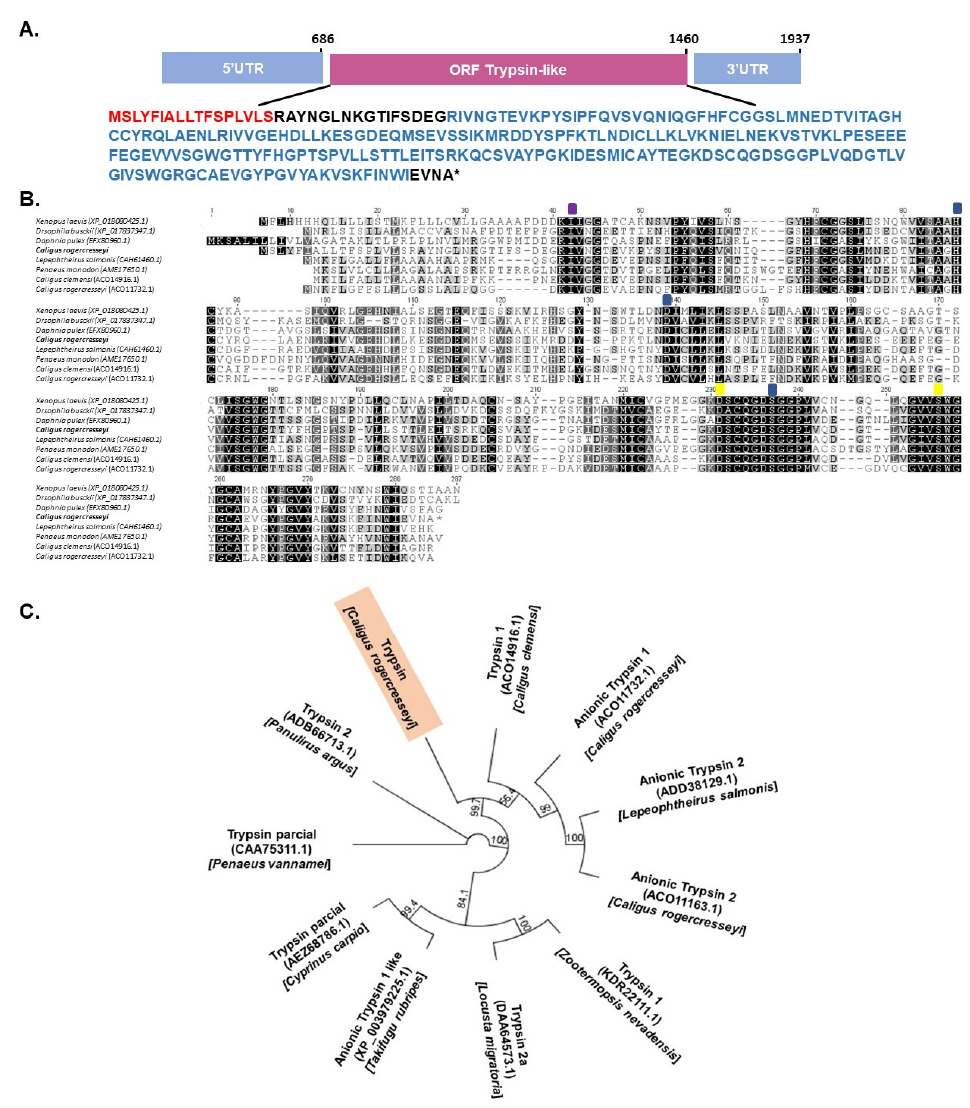
Figure 5. Characterization of trypsin-2 gene in the sea louse C. rogercresseyi . ( A ) Schematic representation of full cDNA of trypsin-2 sequence. In red: peptide signal; in blue: trypsin-like serine protease domain. ( B ) Multiple alignments of trypsin-2 genes. Purple square represents the cleavage site, and yellow squares the substrate union site. The blue squares indicate the active site. ( C ) Phylogenetic analysis of trypsin-2 gene. The tree was constructed by neighbor joining methods, with 1000 bootstrap replicates.